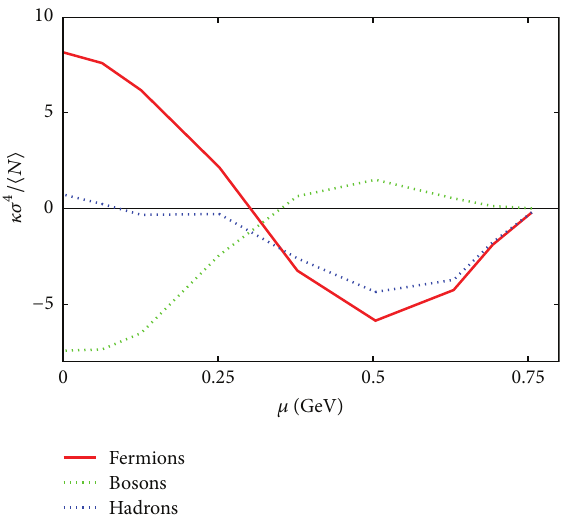
Figure 13: The ratio 𝜅𝜎 4 /⟨𝑁⟩ is given in depending on 𝜇 for boson and fermion resonances.